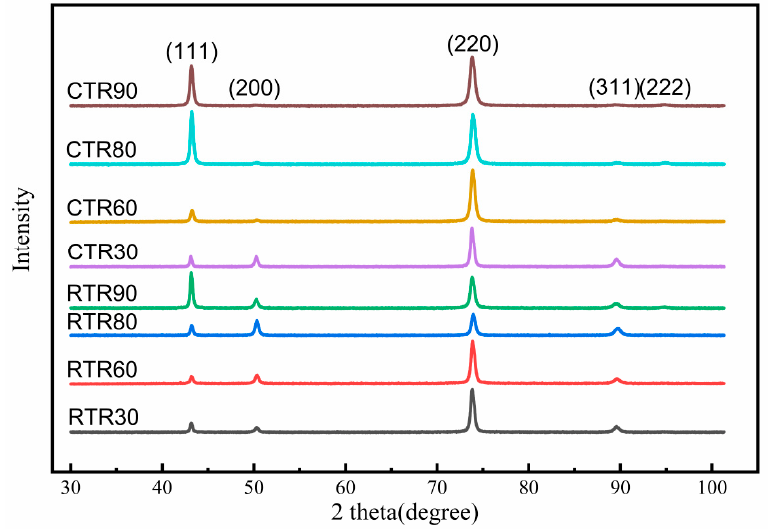
Figure 12. X-ray diffraction results of the RTR samples and CTR samples.